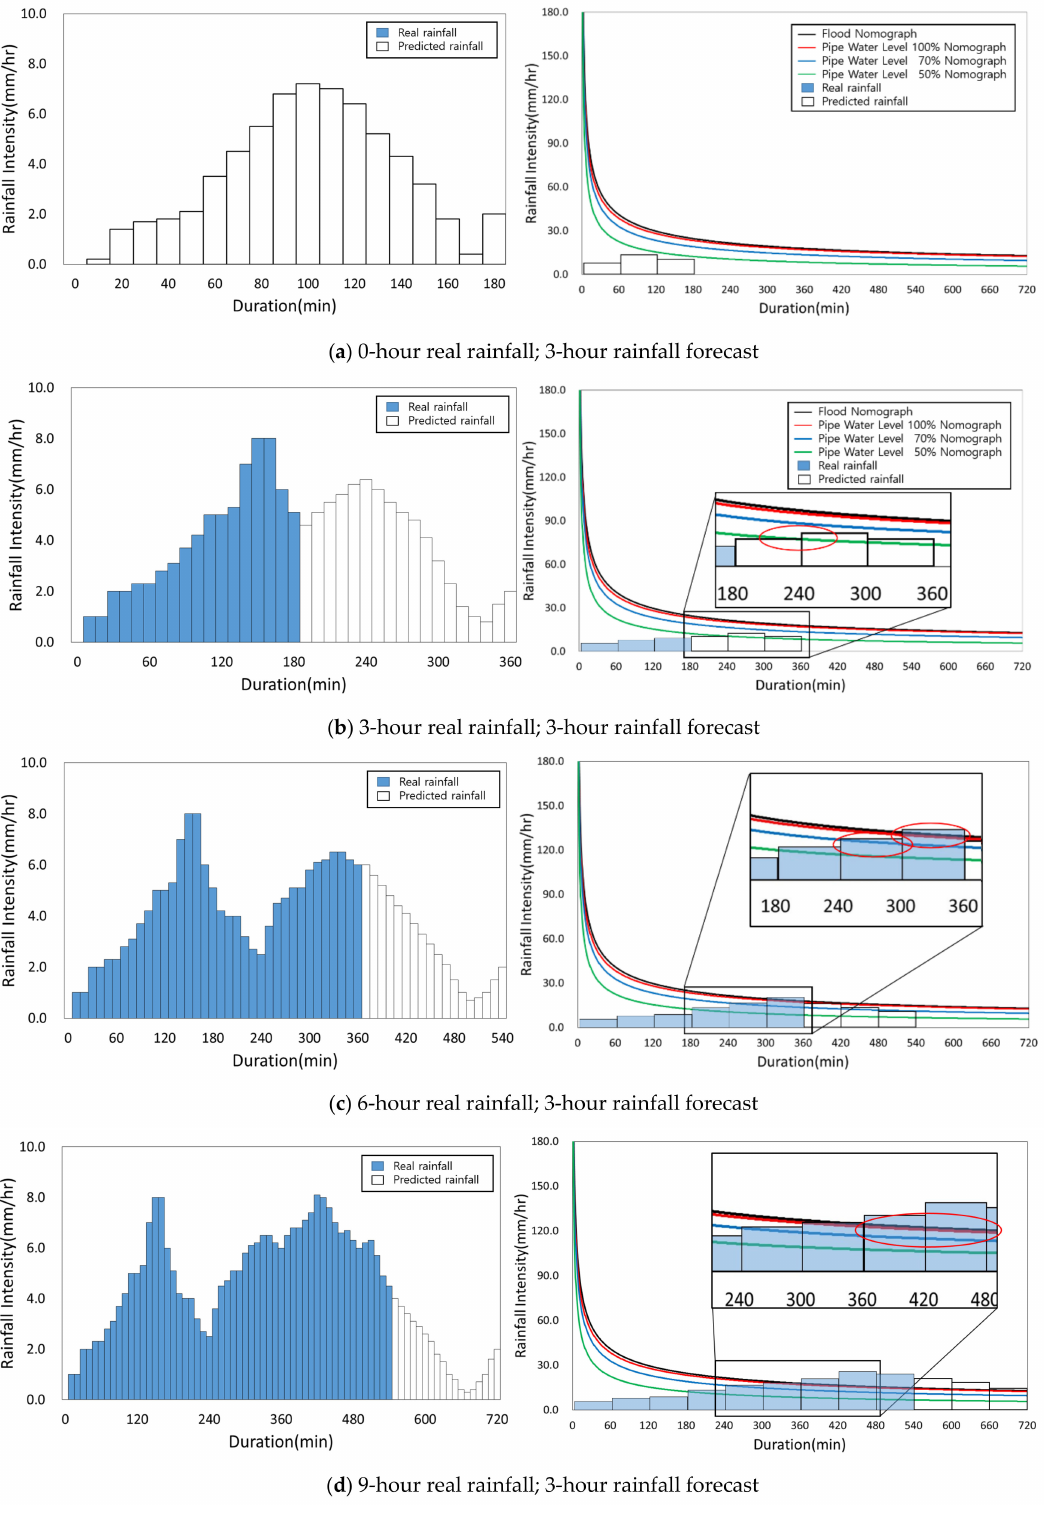
Figure 9. Application of the improved flood nomograph with historical rainfall data (Shincheon